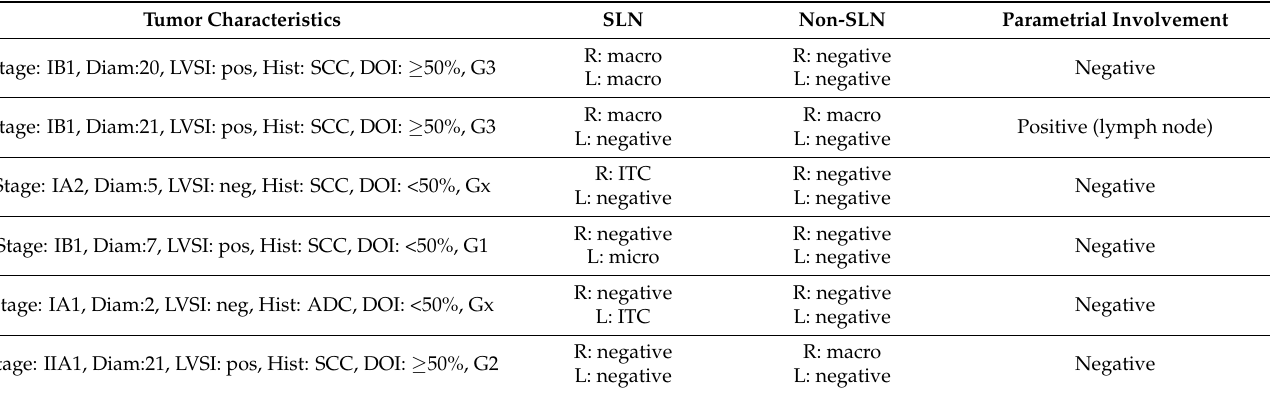
Table 3. Characteristics of patients with metastatic lymph